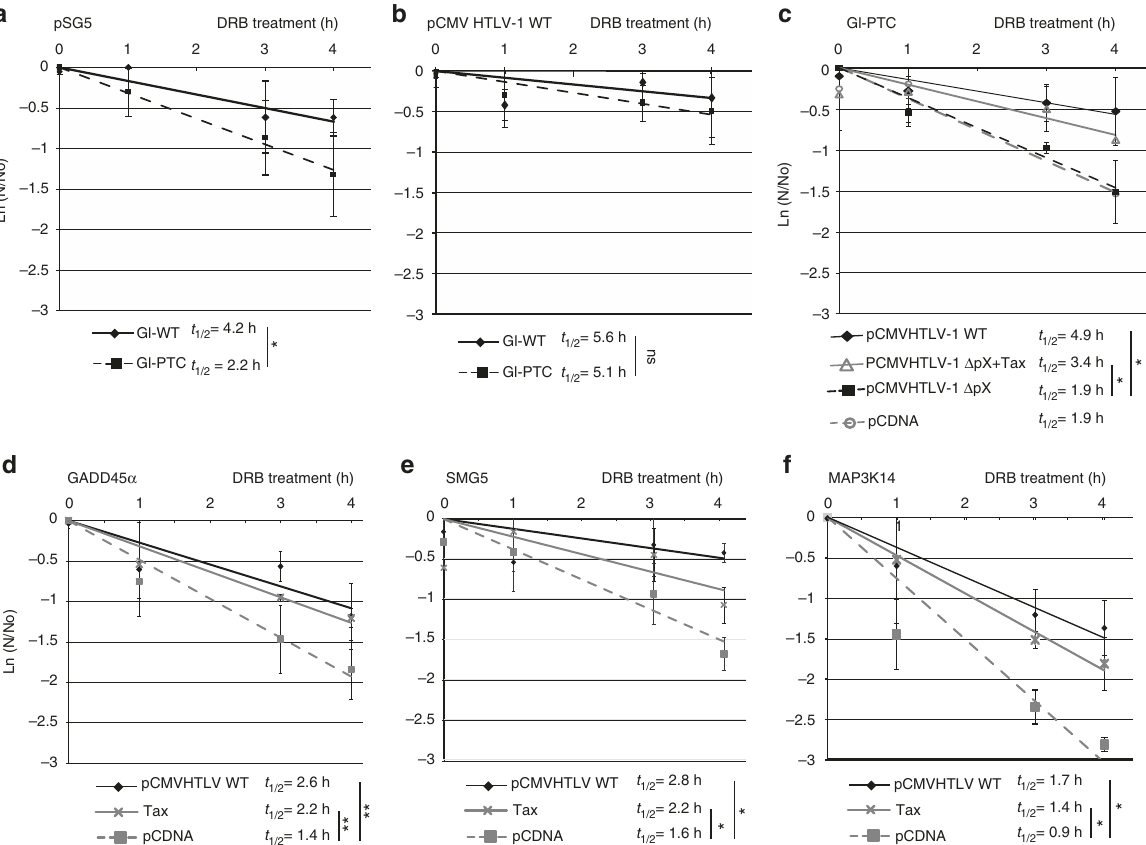
Fig. 1 HTLV-1 Tax protects reporter and endogenous mRNAs from NMD in mammalian cells. a RNA decay assays were carried out in HeLa cells. The stability of Gl-PTC and Gl-WT mRNA was analysed after RNA quanti fi cation by qRT-PCR. mRNA half-lives ( t 1/2 = ln(2)/ λ with λ the time constant of the decay curves) are indicated in front of their respective conditions. b Same as a except that HeLa cells were co-transfected with HTLV-1 molecular clone. c RNA decay assays of Gl-PTC mRNA in the presence of WT HTLV-1 molecular clone (continuous line, diamonds), truncated Δ pX HTLV-1 molecular clone complemented with Tax protein (continuous line, triangle), truncated Δ pX HTLV-1 molecular clone alone (dashed line, square) and empty vector (dashed line, circle). d RNA decay assays examining the stability of endogenous GADD45 α mRNA in the presence of an empty vector (dashed line, square), Tax (continuous line, cross) or a WT HTLV-1 molecular clone (continuous line, diamond; e ), f Same as d with SMG5 and MAP3K14 endogenous mRNA. The values represented in each graph correspond to the mean of at least three biological replicates, and the error bars correspond to the SD. Half-lives were calculated for each replicate, and P values were calculated by performing a Student ’ s t- test (unpaired, two-tailed) ns: P > 0.05; * P < 0.05; ** P <